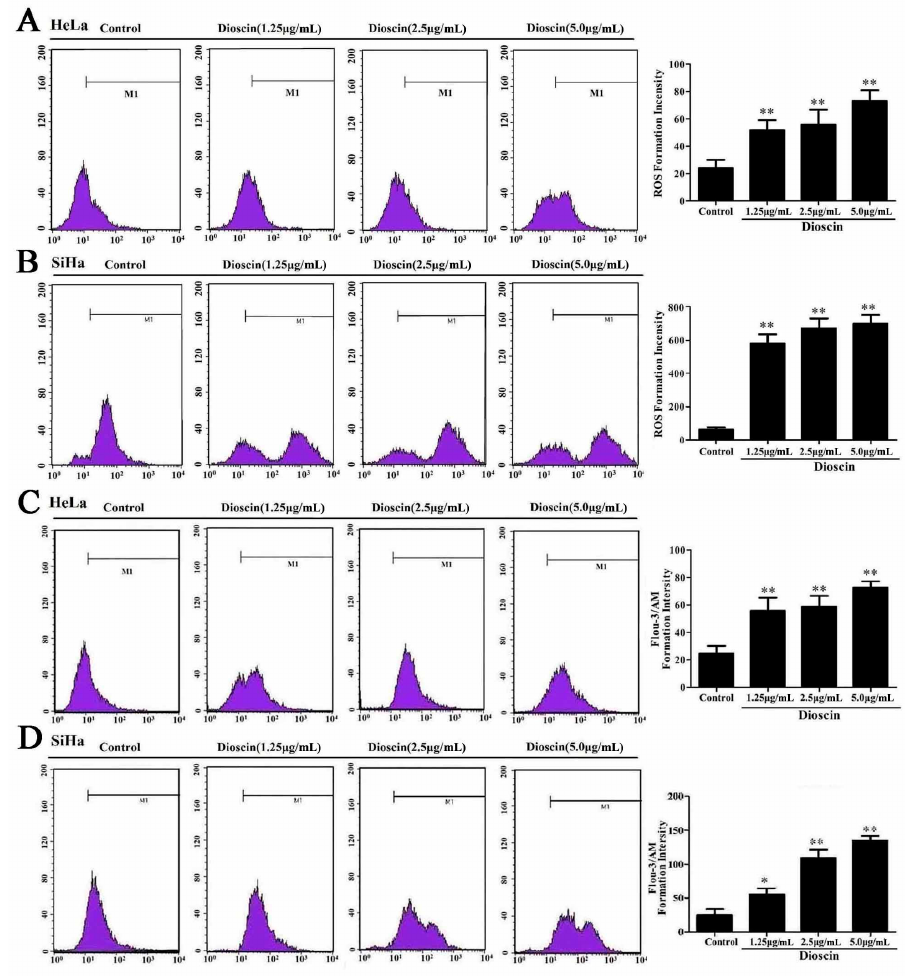
Figure 5. Effects of dioscin on ROS levels and Ca 2+ release. ( A ) ROS generation in HeLa cell treated by dioscin; ( B ) ROS generation in SiHa cell treated by dioscin; ( C ) Effects of dioscin on Ca 2+ level in HeLa cells by flow cytometry; ( D ) Effects of dioscin on Ca 2+ level in SiHa cells by flow cytometry. Data are presented as mean ± SD ( n = 5). * p < 0.05 and ** p < 0.01 compared with control group.